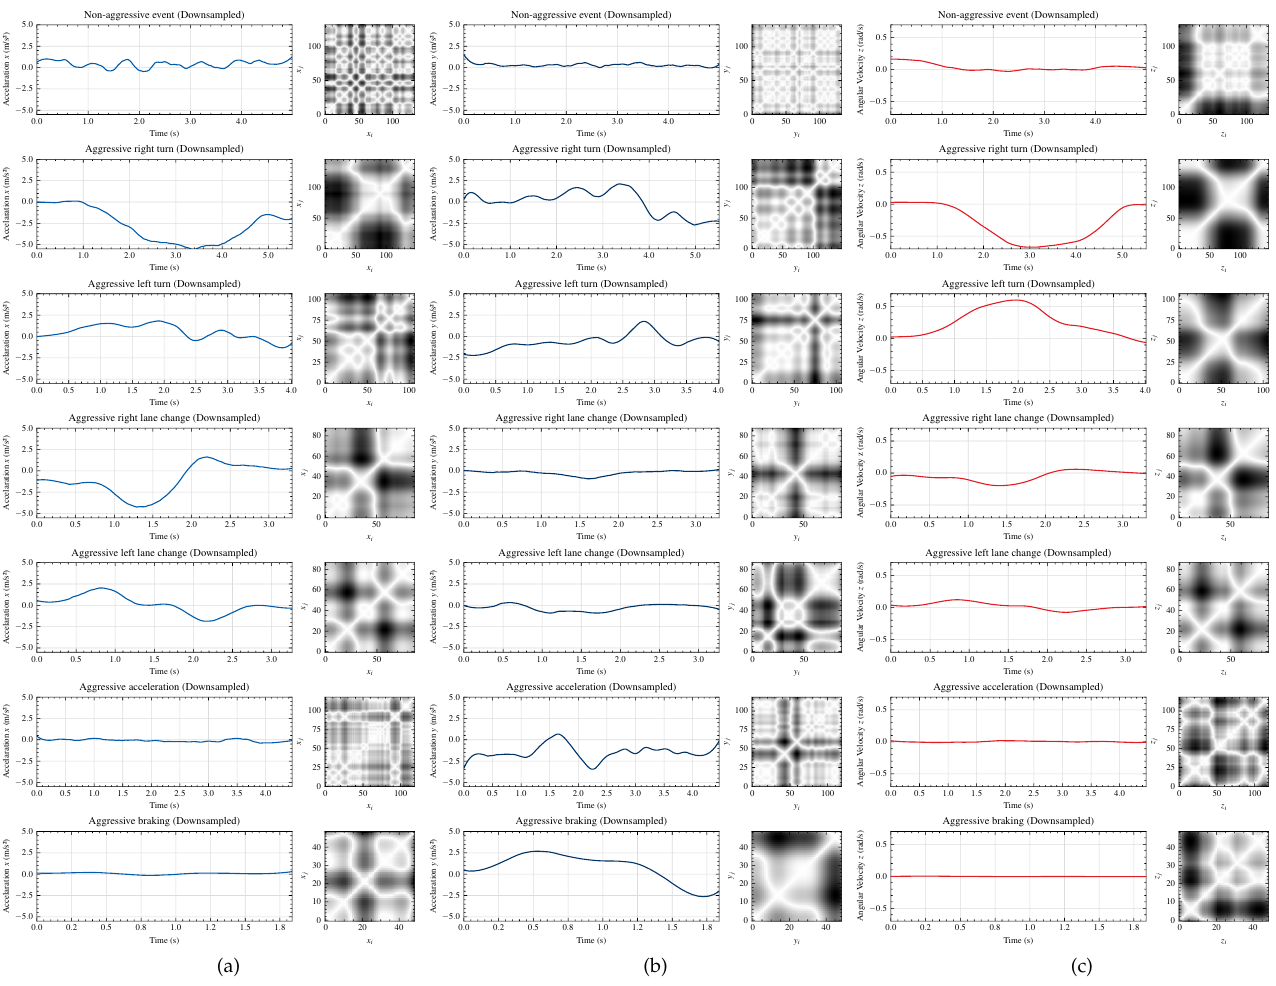
Figure 7. Time series and recurrence plots (on the right side of each driving event) of linear accelera- tion signals in the x and y directions, first ( a ) and second ( b ) columns, and angular velocity in the z direction, third column ( c ).